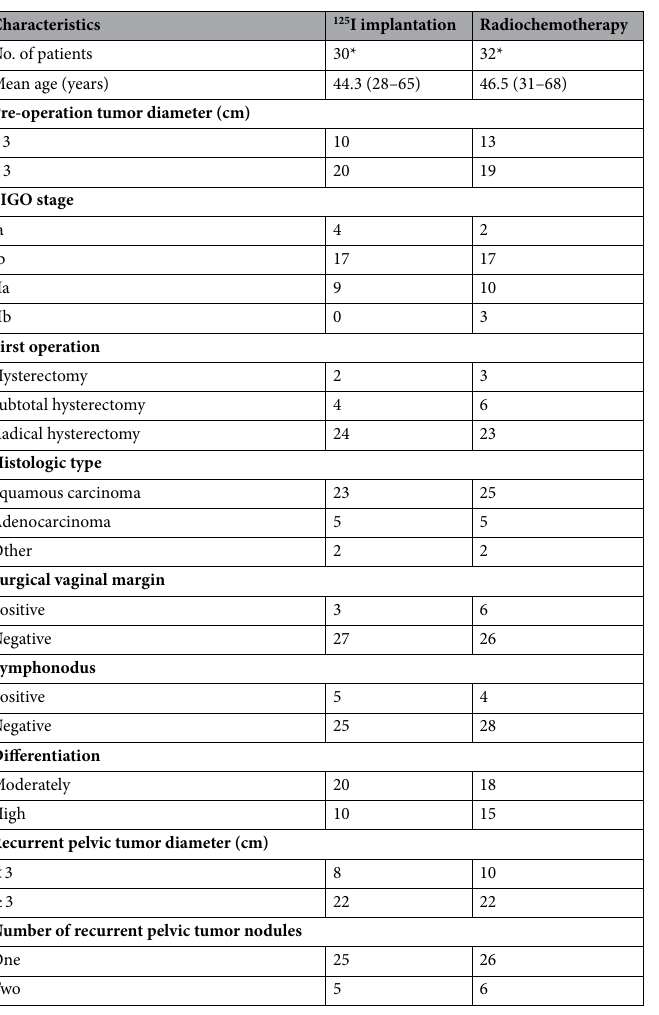
Table 1. Characteristics of 62 patients treated. *For each characteristic, there is no significant difference in comparison for patients who received 125 I implantation and for those who underwent radiochemotherapy ( P > 0.05)